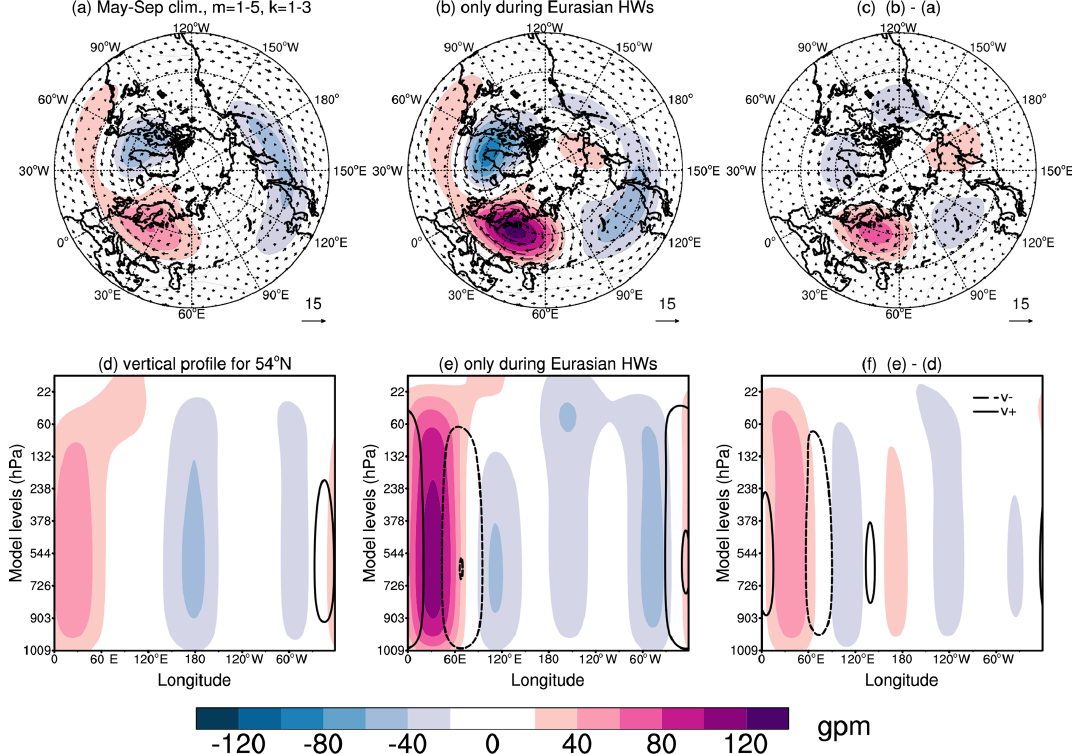
Figure 7. Planetary-scale troposphere–barotropic Rossby waves ( k = 1–3, m = 1–5, all n ) at the σ level close to 500hPa in ERA5. (a) Mean circulation in May–September in 1980–2019, (b) composite of 28 Eurasian heat waves (HWs) presented in Table 1, and (c) difference between panels (b) and (a) . Coloured contours are geopotential height anomalies every 20gpm. The wind speed is shown by the arrow length. (d)–(f) Longitude–pressure cross sections of planetary-scale geopotential height (colours) and meridional wind (isolines) perturbations along 54 ◦ N. (d) Climatology, (e) HWs, and (f) difference between panels (d) and (e) . Solid and dashed contours in panels (d) – (f) correspond to the northward and southward meridional wind speed, respectively, every 2ms − 1